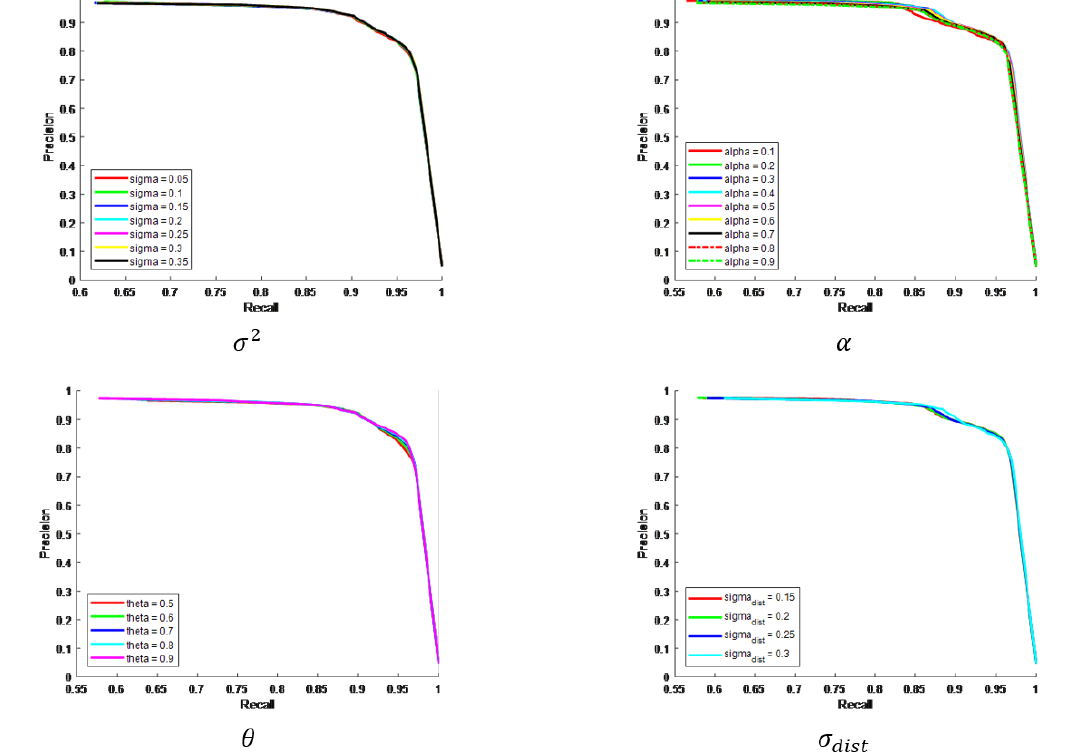
Figure 6. The P–R curve result of four